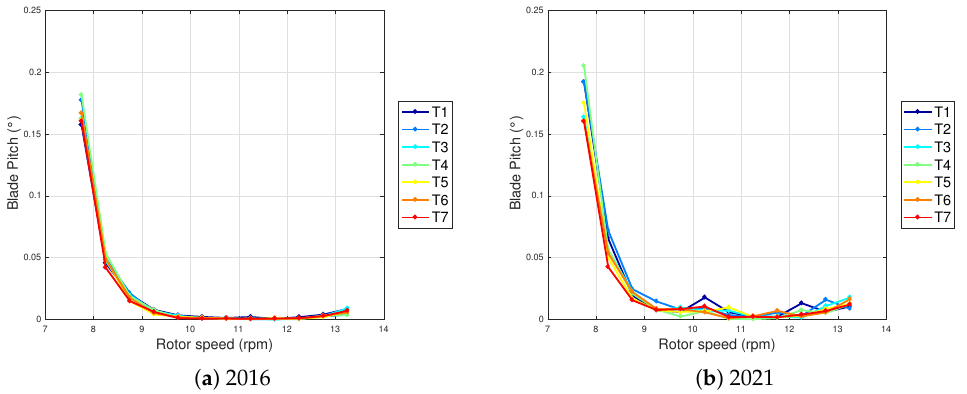
Figure 12. Rotor speed–blade pitch curve for the whole wind farm, computed using the binning